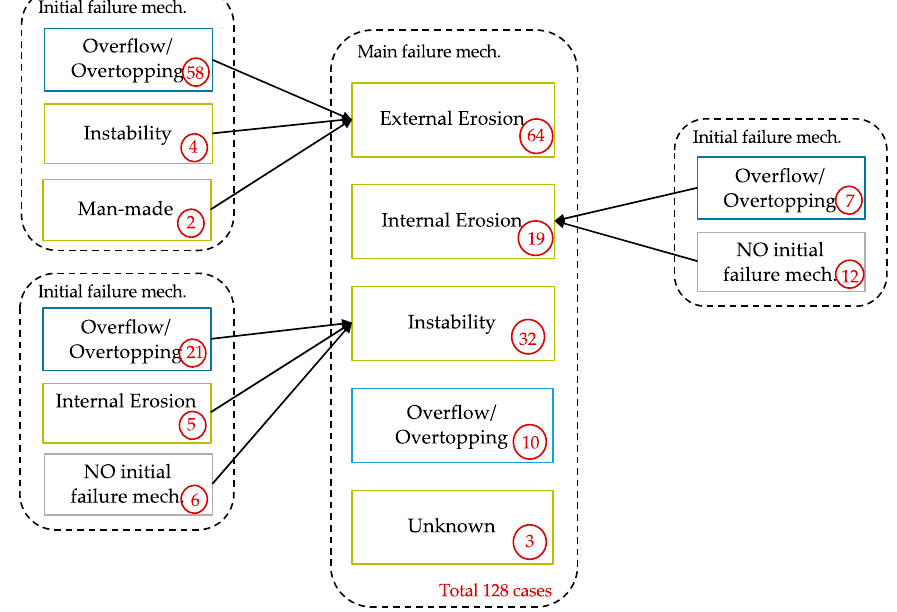
Figure 10. Initial and main failure mechanisms of the failed levees in the Elbe region, Germany, occurred in 2002 and 2013.